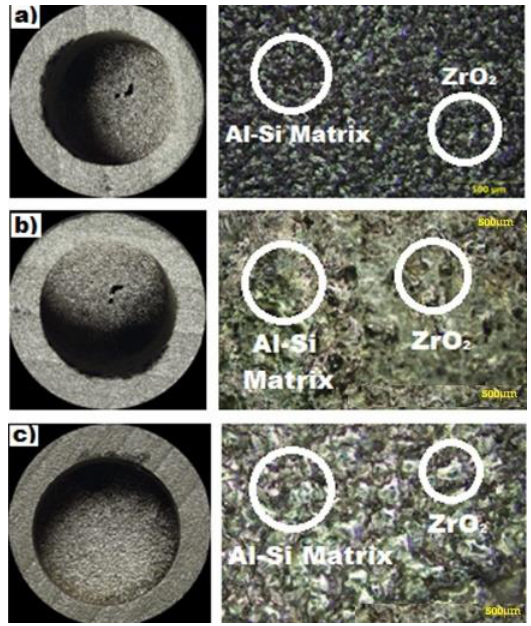
Figure 30. Microstructuralchanges of work piece material ( a – c ).